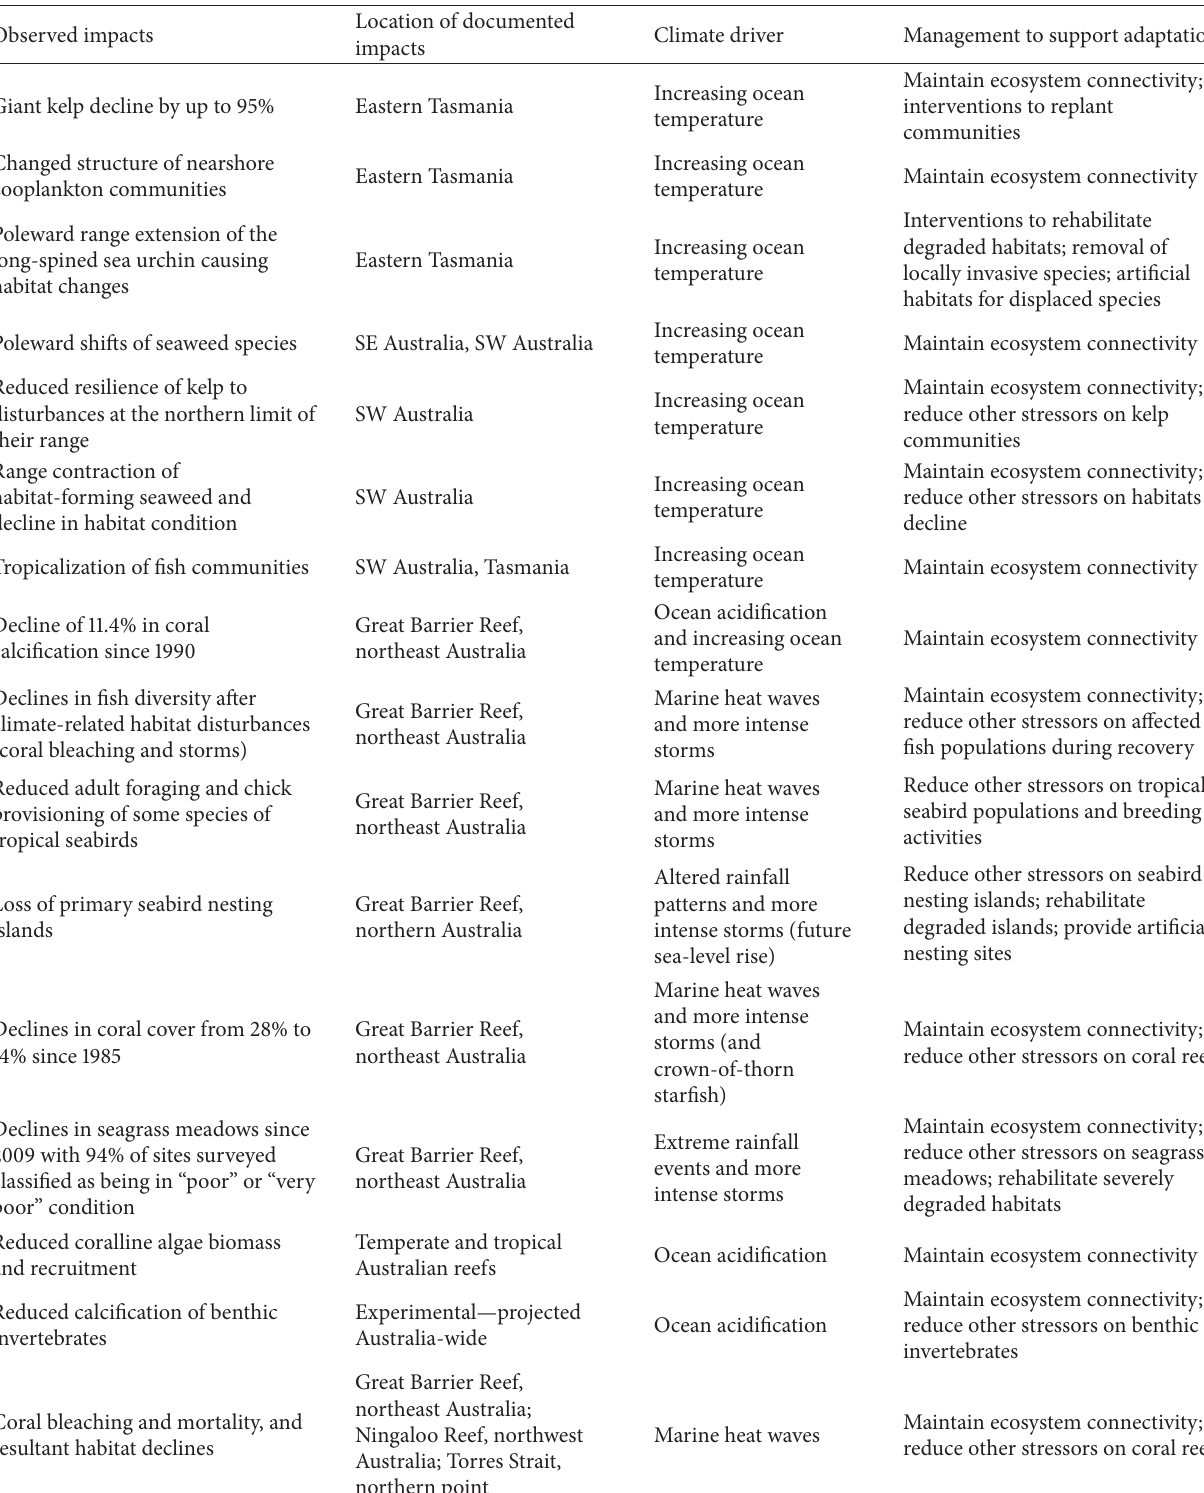
Table 1: Summary of key observed impacts of climate change in Australian marine ecosystems, (locations of these impacts have been documented), main climate driver(s) implicated, and current management options available to support